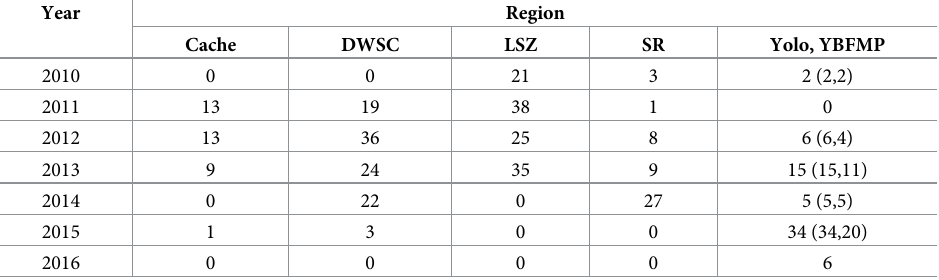
Table 1. Number of juvenile Delta Smelt analyzed for otolith microstructure in this study, sorted by region and year. All fish collected at the Yolo Bypass were genetically confirmed as pure Delta Smelt. Cache is Cache Slough region, DWSC is Sacramento Deep Water Ship Channel, LSZ is low salinity zone, SR is Sacramento River, and Yolo is Yolo Bypass. Numbers in parentheses indicate the number of fish that were also processed for diet analysis, followed by the number of fish with stomach content